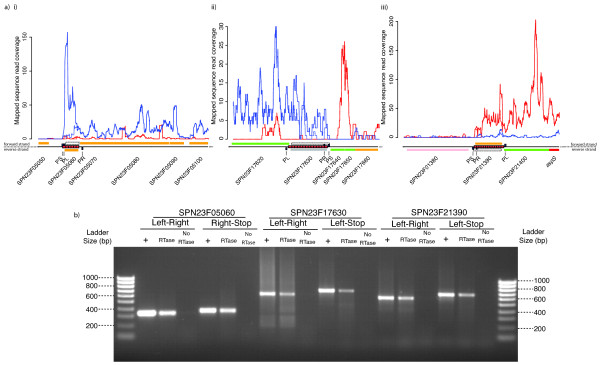
Potential misannotation of the S. pneumoniae ATCC 700669 genome. RNA-seq data is displayed as described in Figure 6. In addition to the published annotation of S. pneumoniae ATCC 700669, dashed boxes indicate alternative open reading frames encoded by BOX elements. a) i) The locus around SPN23F05060, encoded by a BOX element. The CDS is annotated on the bottom strand, but the RNA-seq results indicate it is co-transcribed with the operon on the top strand. ii) This BOX element appears to be cotranscribed with the upstream SPN23F17620 CDS at a low level, rather than encoding the 603 bp putative CDS SPN23F17630. iii) The BOX element encompassing putative CDS SPN23F21390 appears to transcribed on the reverse strand, along with the neighbouring CDSs. b) For each of the three loci displayed in a), two experiments were performed, each as described in Figure 6. One, using PL (left primer) and PR (right primer) tested for expression of the BOX element itself. The second used PL or PR and PS (stop codon primer), which tested whether the full length open reading frame on the transcribed strand was expressed. At all three loci, both reactions were positive using a cDNA sample as template.